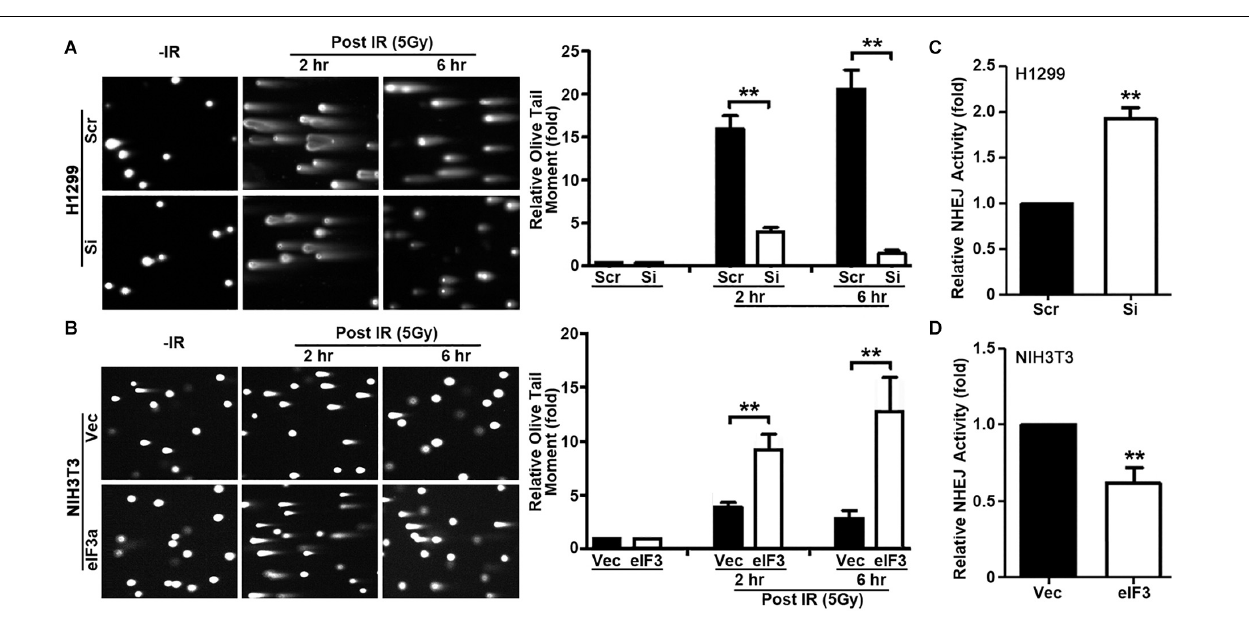
FIGURE 3 | Role of eukaryotic initiation factor (eIF)3a in non-homologous end joining (NHEJ) repair of ionizing radiation (IR)-induced double-strand breaks (DSBs). (A,B) Comet assay was used to determine eIF3a effects on the level of DSBs induced by IR in H1299 cells with transient eIF3a knockdown (A) and NIH3T3 cells with stable eIF3a overexpression (B) compared with their respective control cells. The histograms show the summary of quantitative analysis of Olive tail moment in these cells. (C,D) Host cell reactivation assays using reporter constructs were performed using H1299 cells with eIF3a knockdown (C) and NIH3T3 cells with eIF3a stable overexpression (D) compared with their respective control cells ( n = 3; ** P <